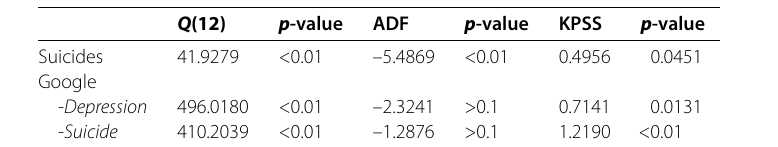
Table 2 Autocorrelation and unit-root tests